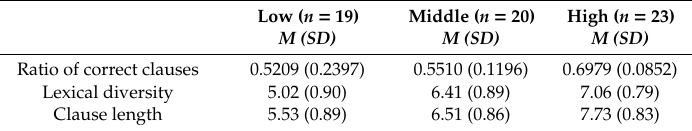
Table A2. Linguistic measures descriptive statistics.